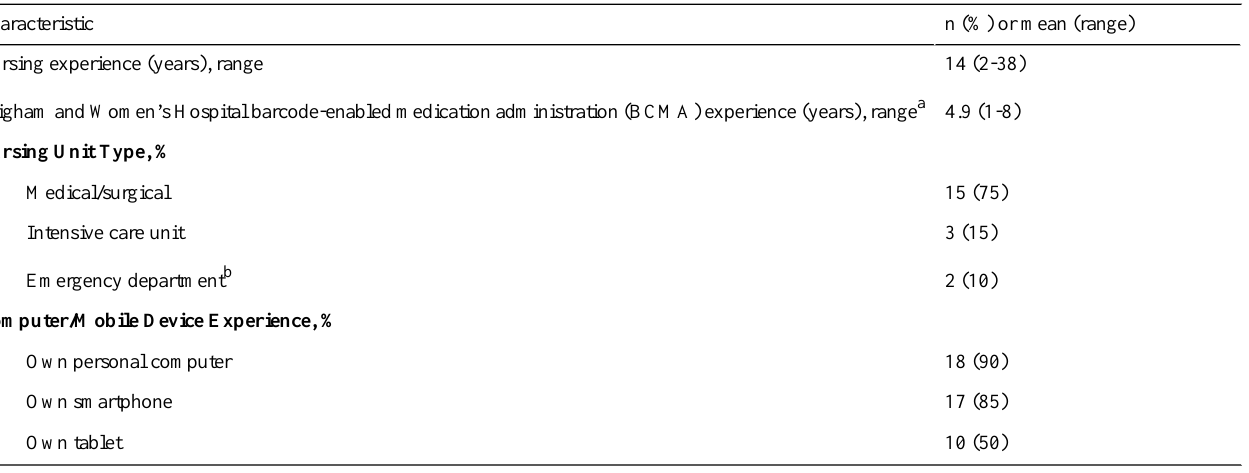
Table 2. Nursing participant characteristics